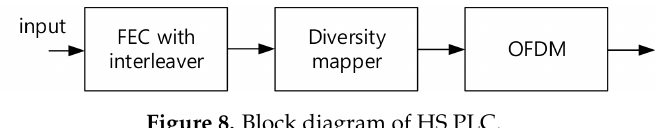
Figure 8. Block diagram of HS